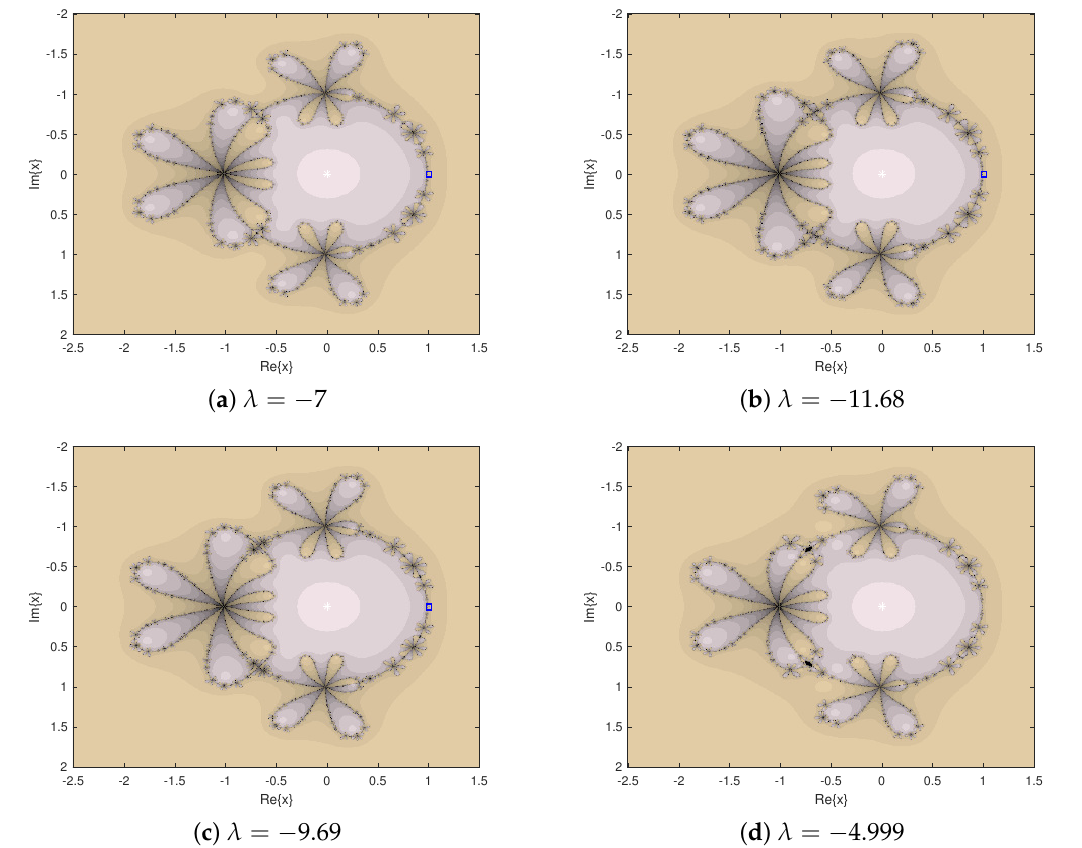
Figure 4. Dynamical planes for special λ